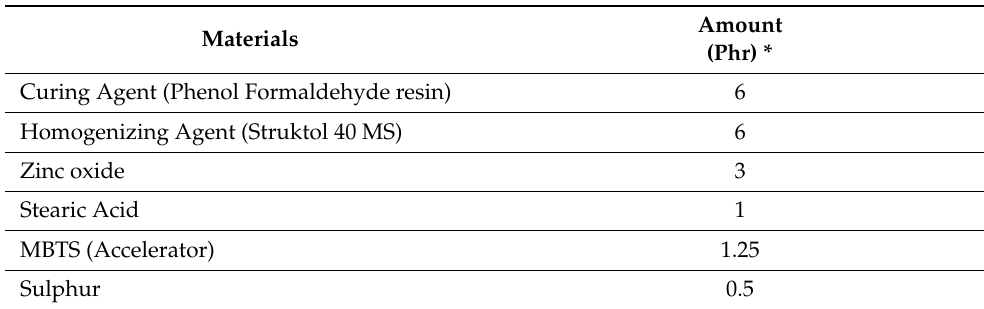
Table 1. Compounding materials used for the preparation of CIIR/NR blend nanocomposites. * Phr—parts per hundred rubber by weight.